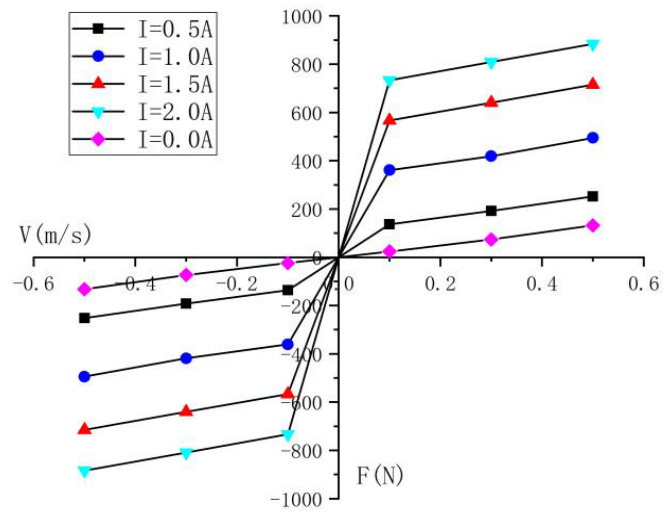
Figure 10. Output of damping force under low-speed vibration. Viscosity and velocity nephograms at the damping channel under a constant velocity motion of 0.1 m/s and 0.5 m/s are shown in Figures 11 and 12. When the velocity is 0.1 m/s, it can be seen that the damping channel activation area viscosity distribution is uniform, the activation area basically has regular structure flow, the viscosity of the two sides near the wall’s shear rate has a larger decrease, and the velocity of the non-activation area in the middle of the damping channel is higher; moreover, there will be an obvious backflow phenomenon because the high-viscosity area at both ends of the blocking effect leads to liquid backflow. When the velocity is 0.5 m/s, the viscosity distribution nephogram is different to when the velocity is 0.1 ms, and the structure flow of the activation area is not regular. When the current is higher, the viscosity distribution of the right activation area is not uniform and the inlet of the viscosity is lower. Because the current is higher, the shear yield stress is larger, so it can barely form a structure flow. When the current is reduced to 0.5 A, it can be found that the right inlet of the viscous flow and the damping channel structure of the flow are not increased.